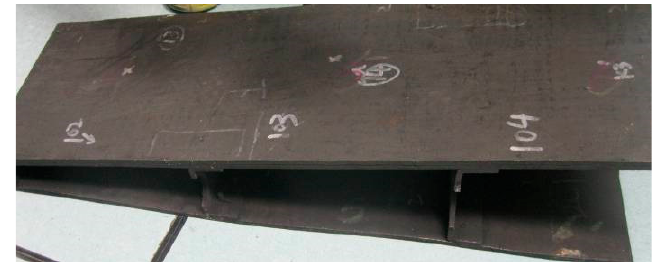
Figure 1. C/SiC composite component.